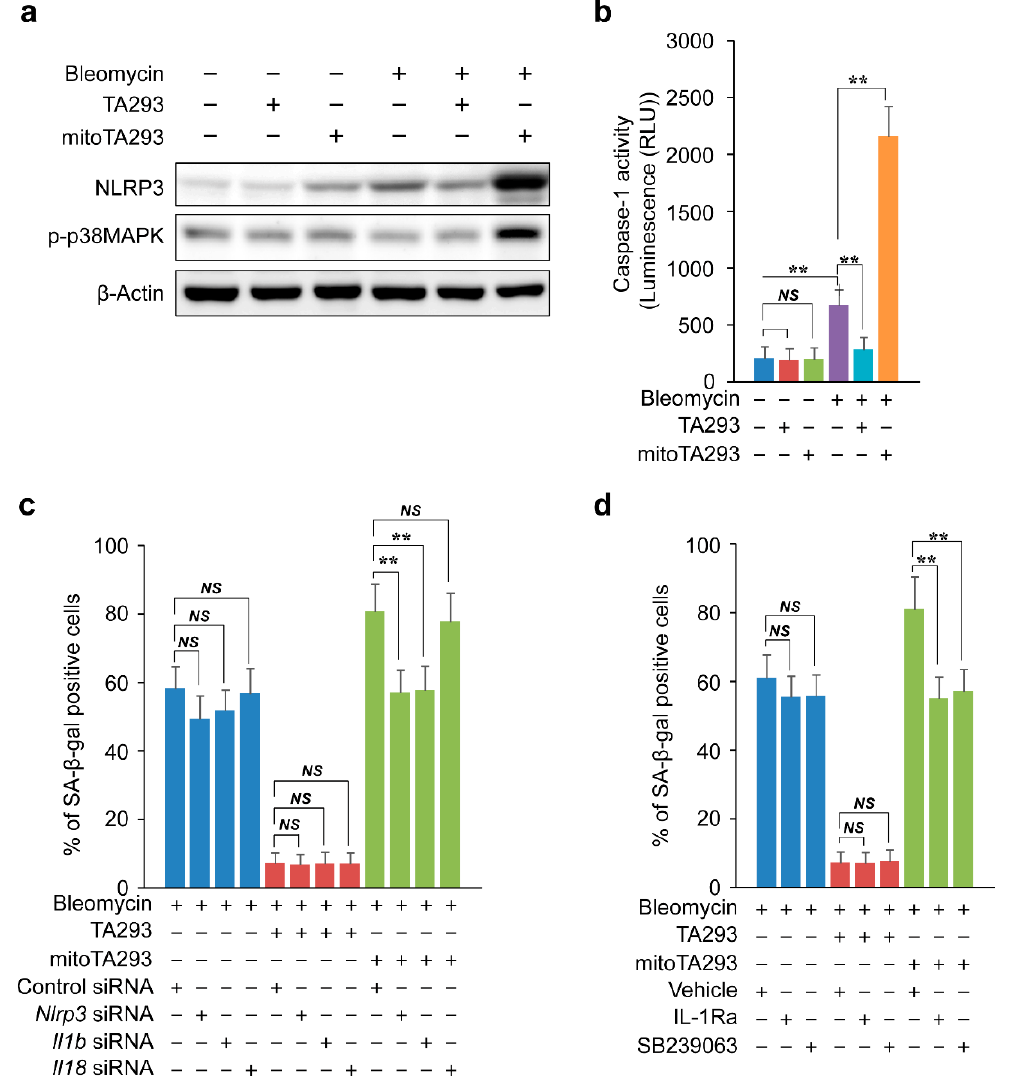
Figure 7. Effects of TA293 and mitoTA293 on NLRP3 inflammasome-induced cellular senescence in BLM-induced PAECs in vitro . ( a ) Expression of NLRP3 and phosphorylation of p38MAPK visualized by western blotting. ( b ) Caspase-1 activity based on luminescence analysis. ( c ) Effects of Nlrp3 , Il1b , and Il18 siRNAs on cellular senescence. ( d ) Effects of ILa1R and SB239063 on cellular senescence. PAPEs were treated with saline or BLM and with vehicle, TA293, or mitoTA293 for 72 h. The data are presented as the mean ± SEM ( n = 5 per group); ** p < 0.01; NS , not significant.